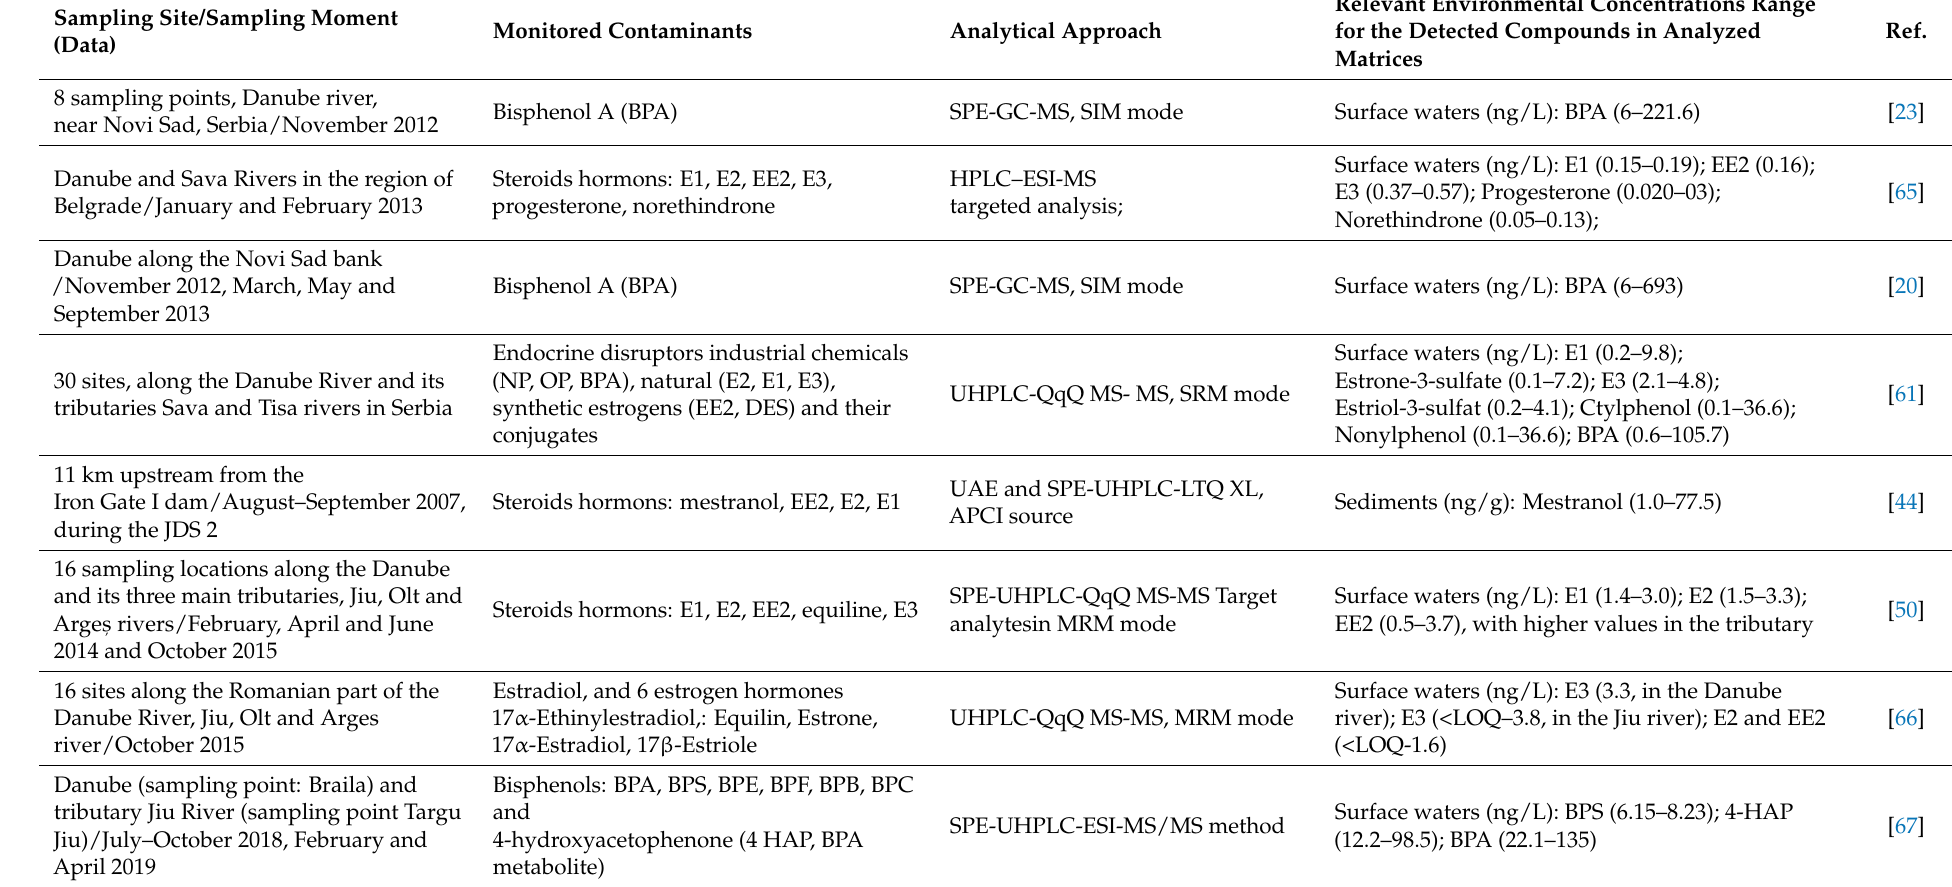
Table 2. Summary of the publication during 2010–2021 on the area of Low Danube and North-West Black Sea Basins concerning endocrine disruptors contaminants. Sampling Site/Sampling